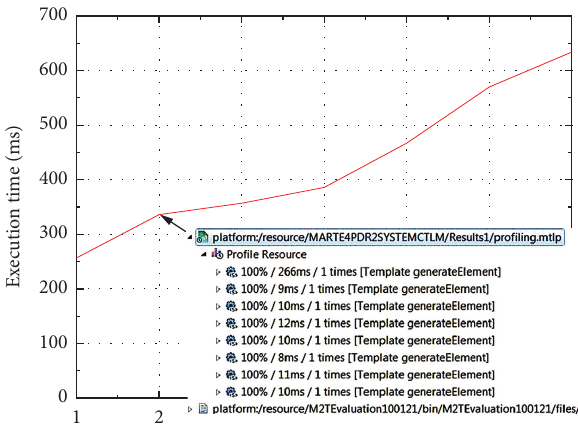
Figure 25: The generation process profiling results.